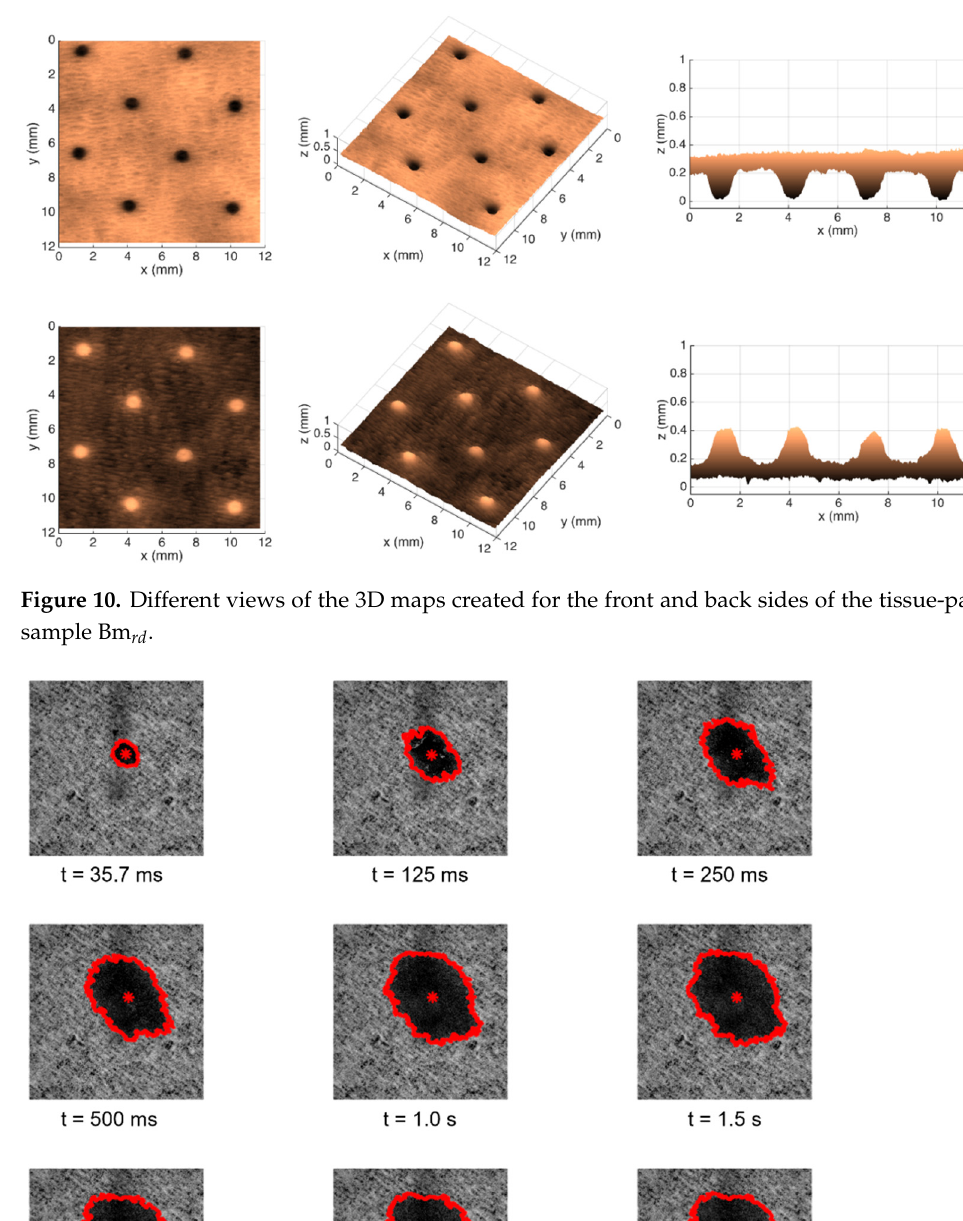
Figure 9. Different views of the 3D maps created for the front and back sides of the tissue-paper sample Bm sd .